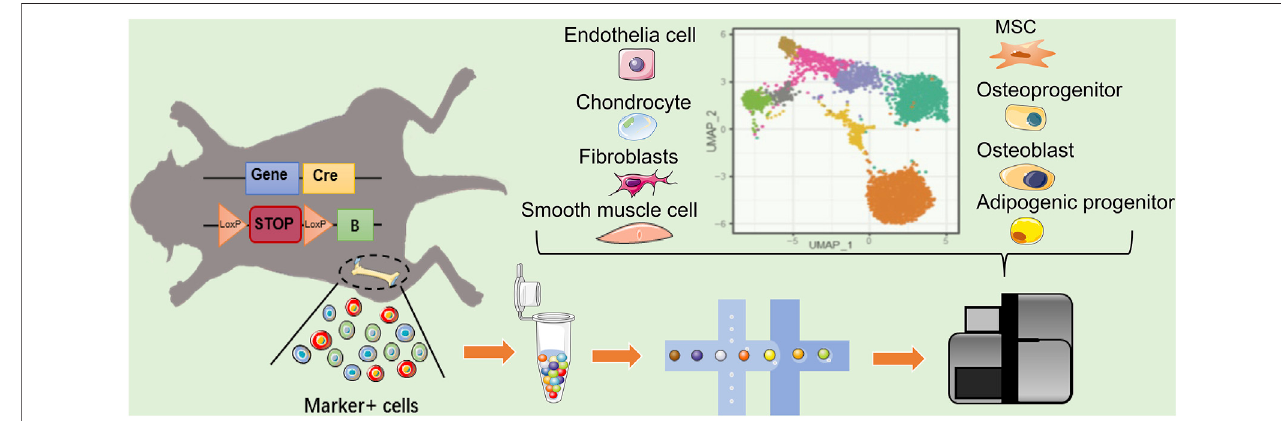
FIGURE2| SinglecellrevealstheheterogeneityofMSCsmarkerstargetingcells.InmicewithCre – loxPrecombinationsystem,theMSCmarkersgeneexpressing- cells will be fl uorescently labeled. When two loxP sites exist in the same DNA strand with the same orientation, terminator between two loxP will be removed by Cre, allowing the fl uorescent protein to be expressed. The heterogeneity of labeled MSCs can revealed by scRNA-seq. In addition to MSC, the existing MSC marker-labeled cell population may include Osteo- and adipo-lineage cells, chondrocytes, epithelial cells, and fi broblast smoothmuscle cells, etc. Bluesquare:MSC markergene; yellow square: cyclization recombination enzyme gene; red rounded rectangle: stop codon; orange triangle: speci fi c recognition site of Cre recombinase; green square: fl uorescent